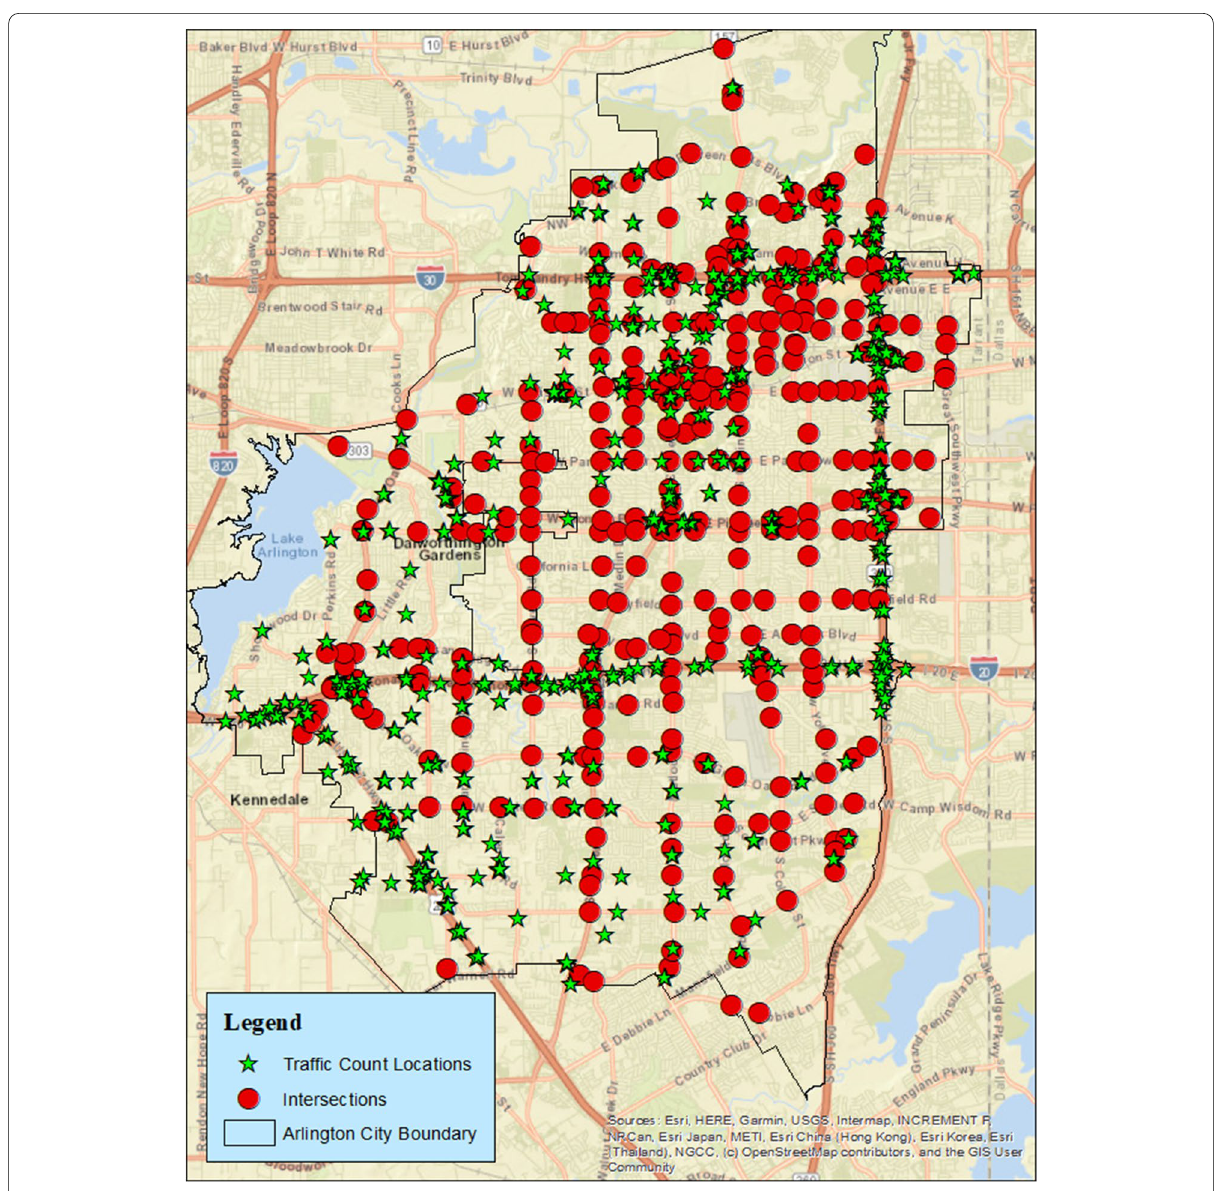
Fig. 1 Study area and traffic count locations